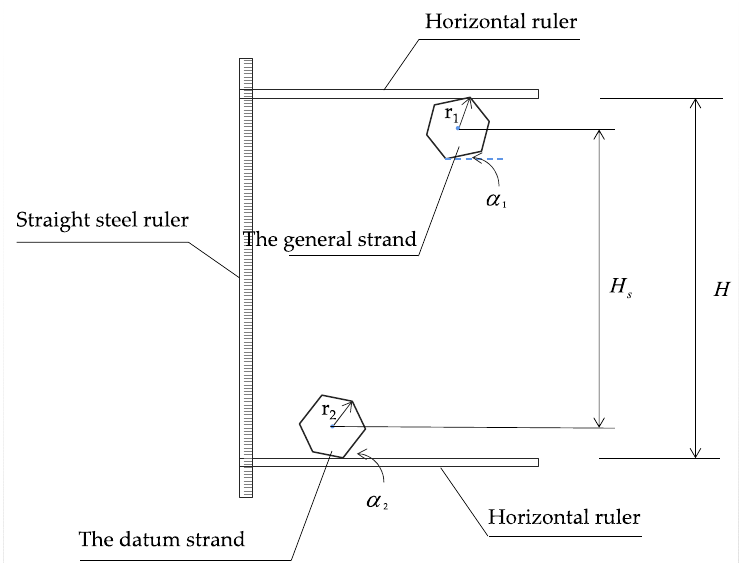
Figure 2. Measurement principle of the conventional method.